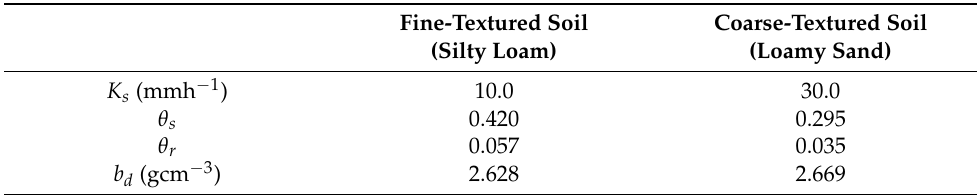
Table 2. Main hydraulic properties of study soils. K s = saturated hydraulic conductivity; θ s and θ r = saturated and residual water content, respectively; b d = bulk density.